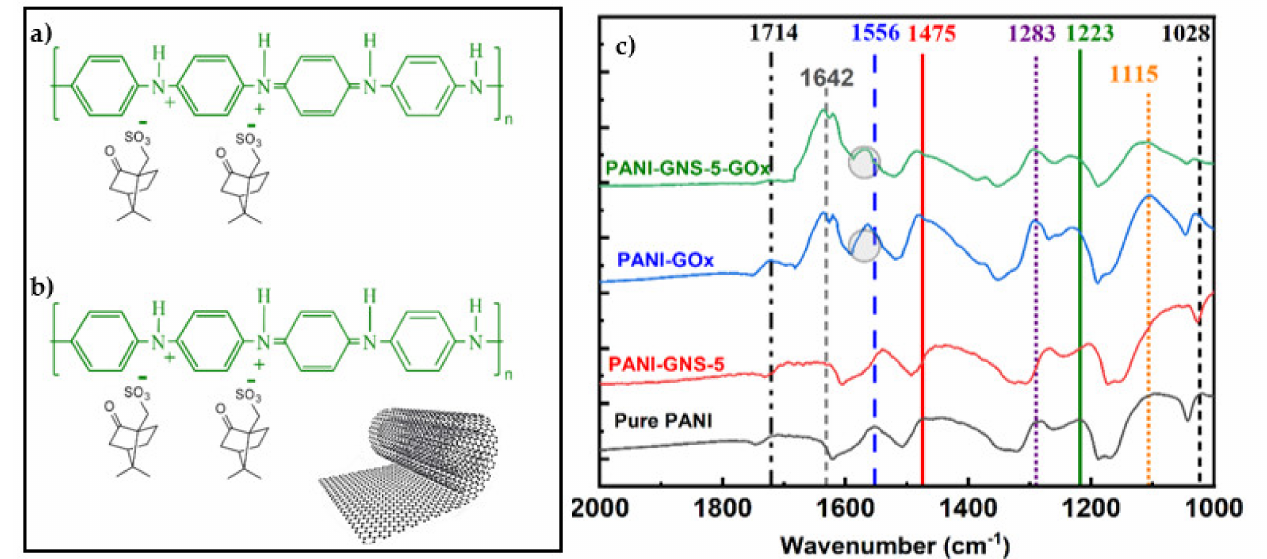
Figure 2. Chemical structure of CSA-doped ( a ) PANI, ( b ) PANI-GNS; ( c ) FTIR Spectra of PANI, PANI-GNS-5, PANI-GOx, and PANI-GNS-5-GOx